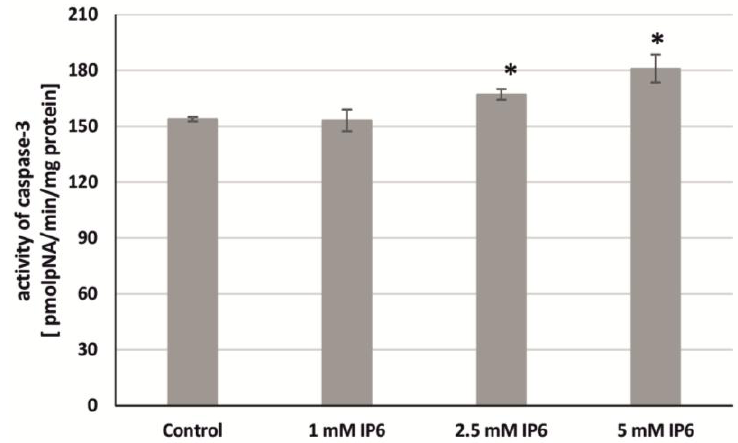
Figure 6. Effect of InsP6 at concentrations of 1 mM, 2.5 mM and 5 mM on the caspase-3 activity in Caco-2 cells at 24 h. The results are presented as mean ± SD of three separate experiments; * p < 0.05 vs. control.